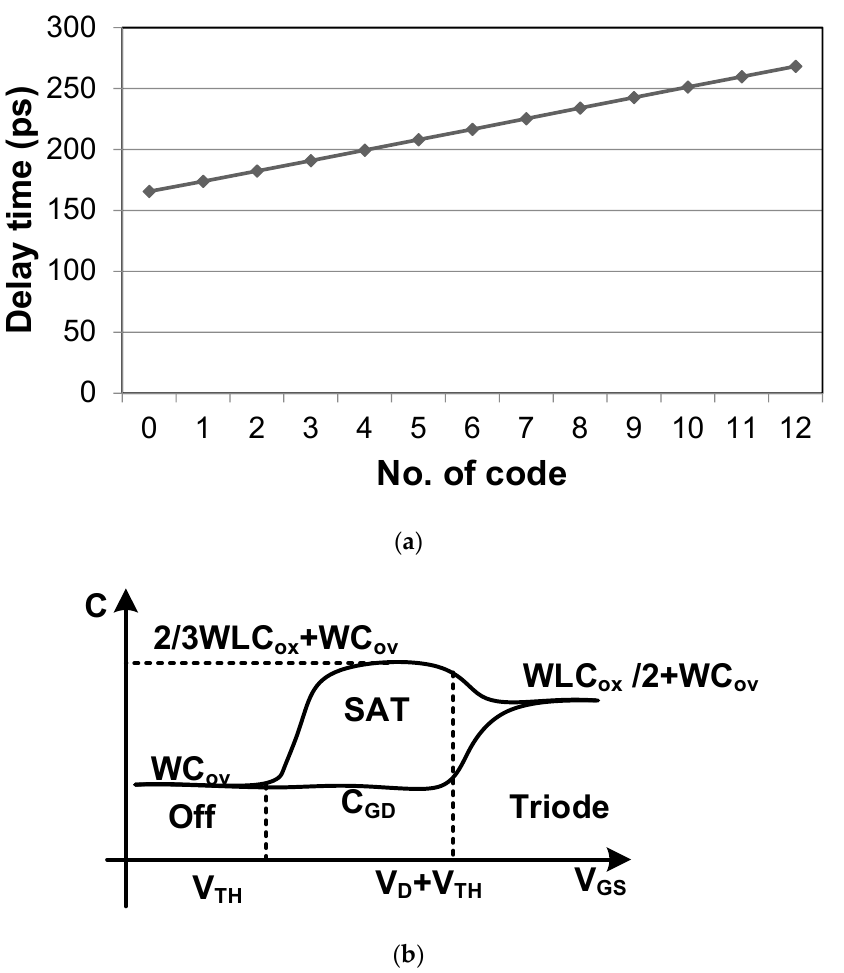
Figure 7. ( a ) Delay time of the Fine Delay Line; ( b ) Variation of capacitance versus V GS .